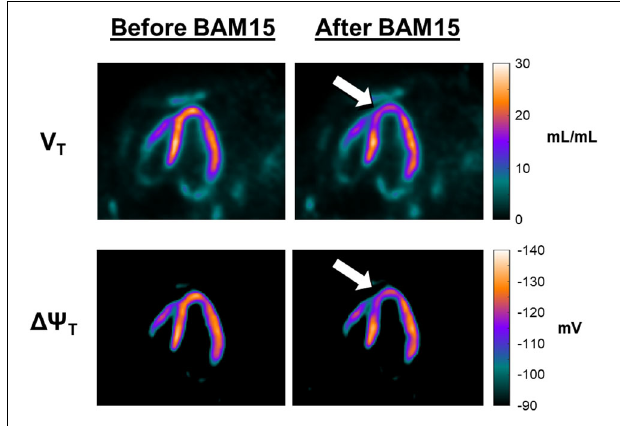
FIGURE 3 | Effect of BAM15 on 18 F-TPP + volume of distribution (V T ; top) and tissue membrane potential ( (cid:49)(cid:57) T ; bottom). Shown are vertical long axis projections of the pig heart, with the apex facing the top of page. The images in the left column are from data acquired before infusion of BAM15. Images on the right were obtained during a secular equilibrium during BAM15 infusion. The color bars, to the right of each row, provide a quantitative index of the parameters. The white arrows serve to guide the eye toward areas of the myocardium depolarized by BAM15 infusion. Intracoronary infusion of BAM15 in the left anterior descending artery reduces the V T of the tracer in apical and apical septal segments of the myocardium. Corresponding depolarization of the (cid:49)(cid:57) T is demonstrated by comparison of the before and after BAM15 images.